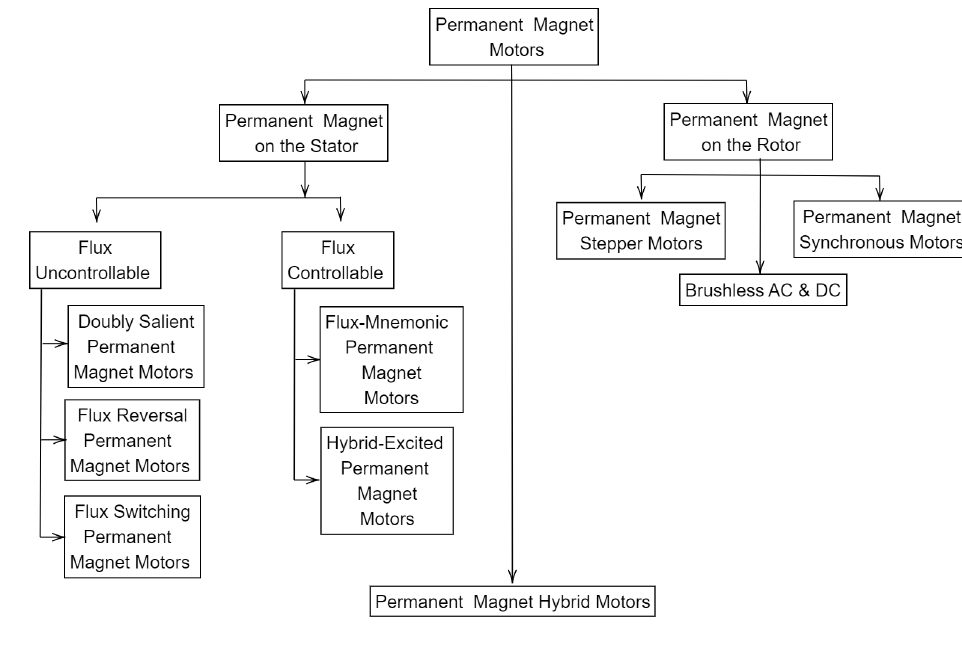
Figure 1. Classification of permanent magnet motors.